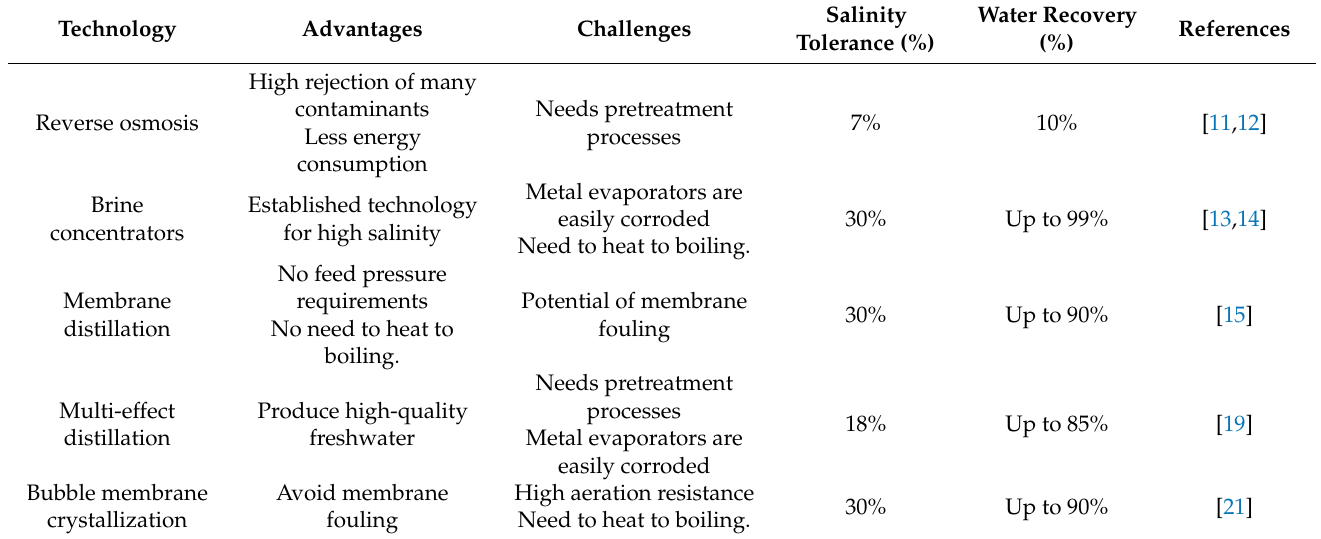
Table 1. An overview of Minimal liquid discharge treatment